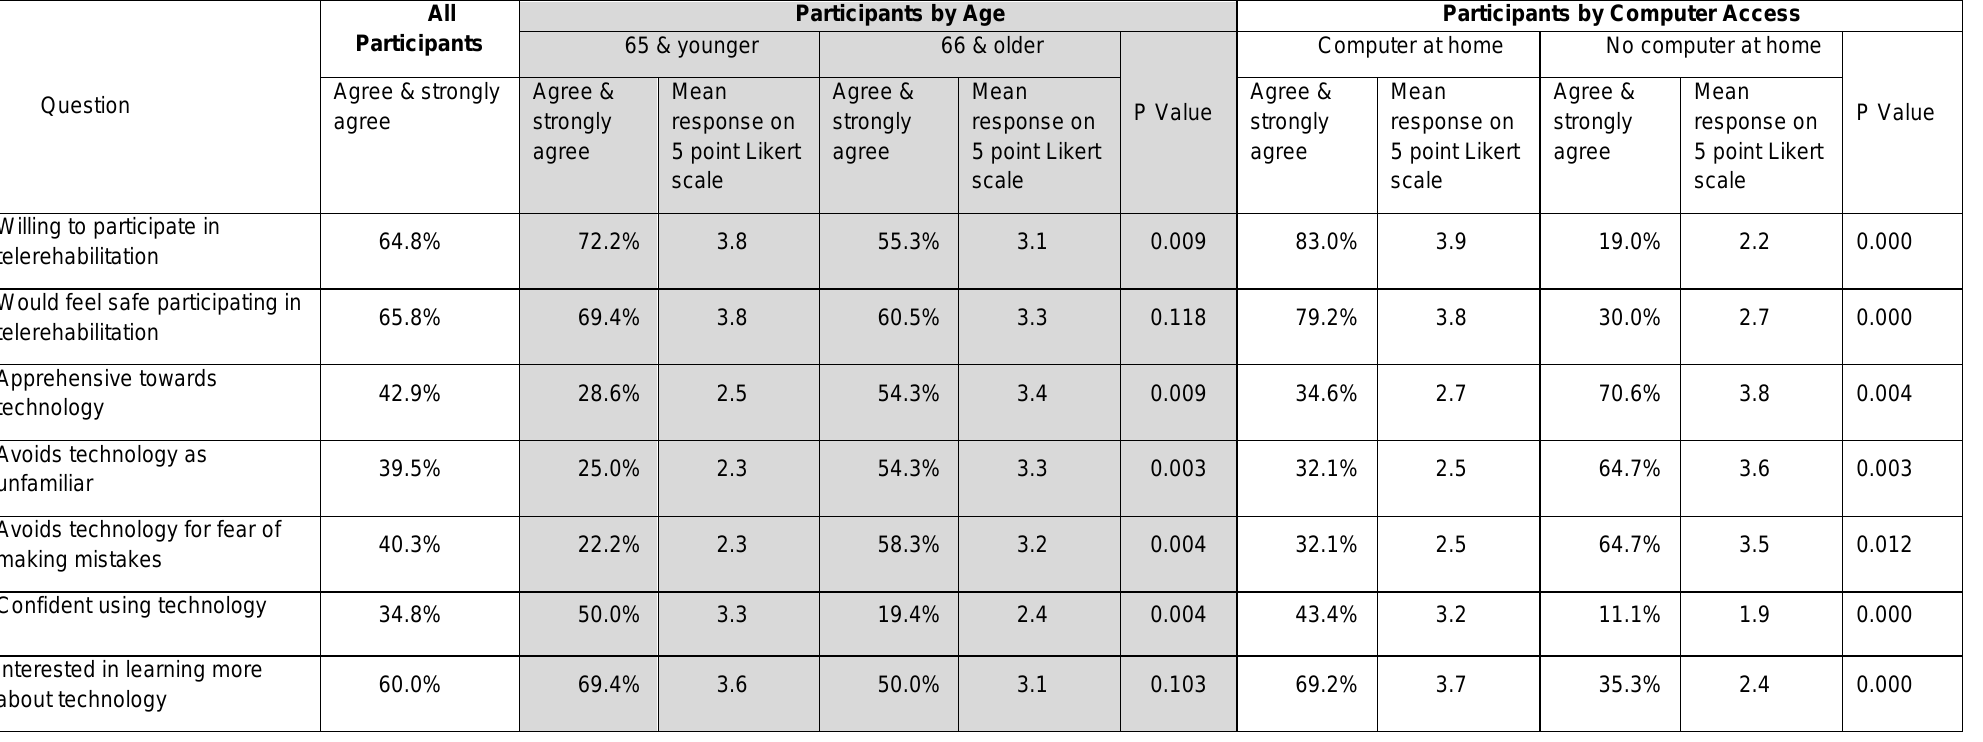
Table 1. Feelings towards Telerehabilitation and Technology